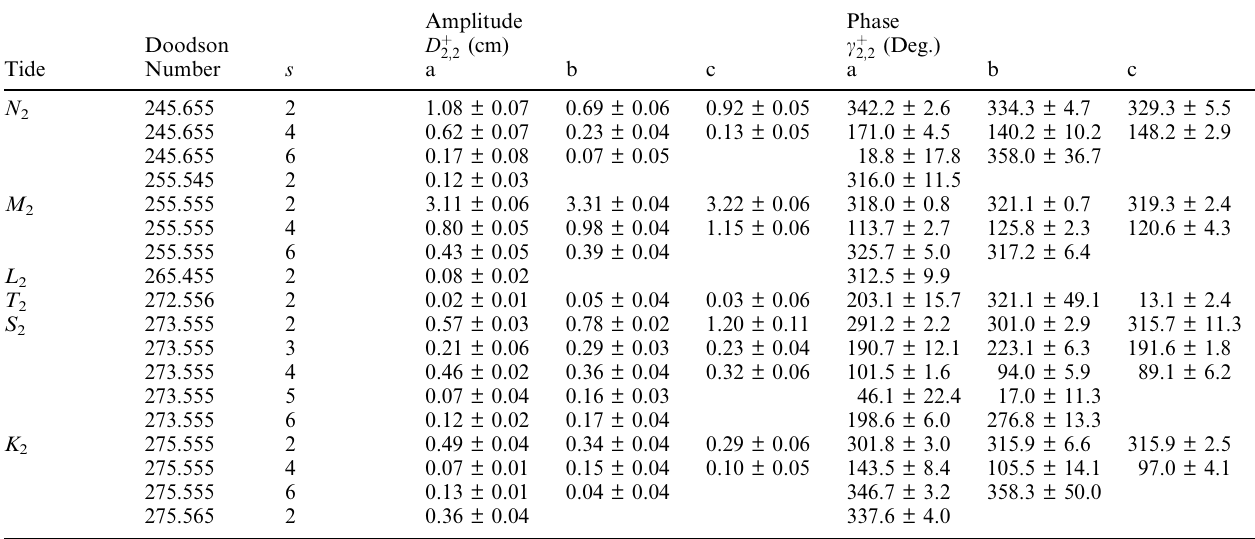
Table 3. Semi-diurnal ocean-tide parameters from the final fitting (a (cid:136) thisanalysis ; b (cid:136) GEM-T3 ; c (cid:136) Cheng)